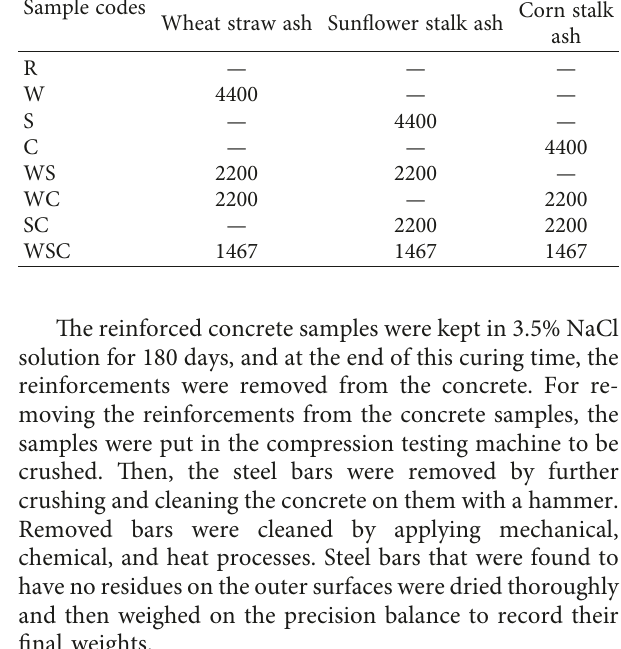
Table 4: Component amounts in the concrete mixtures. Materials